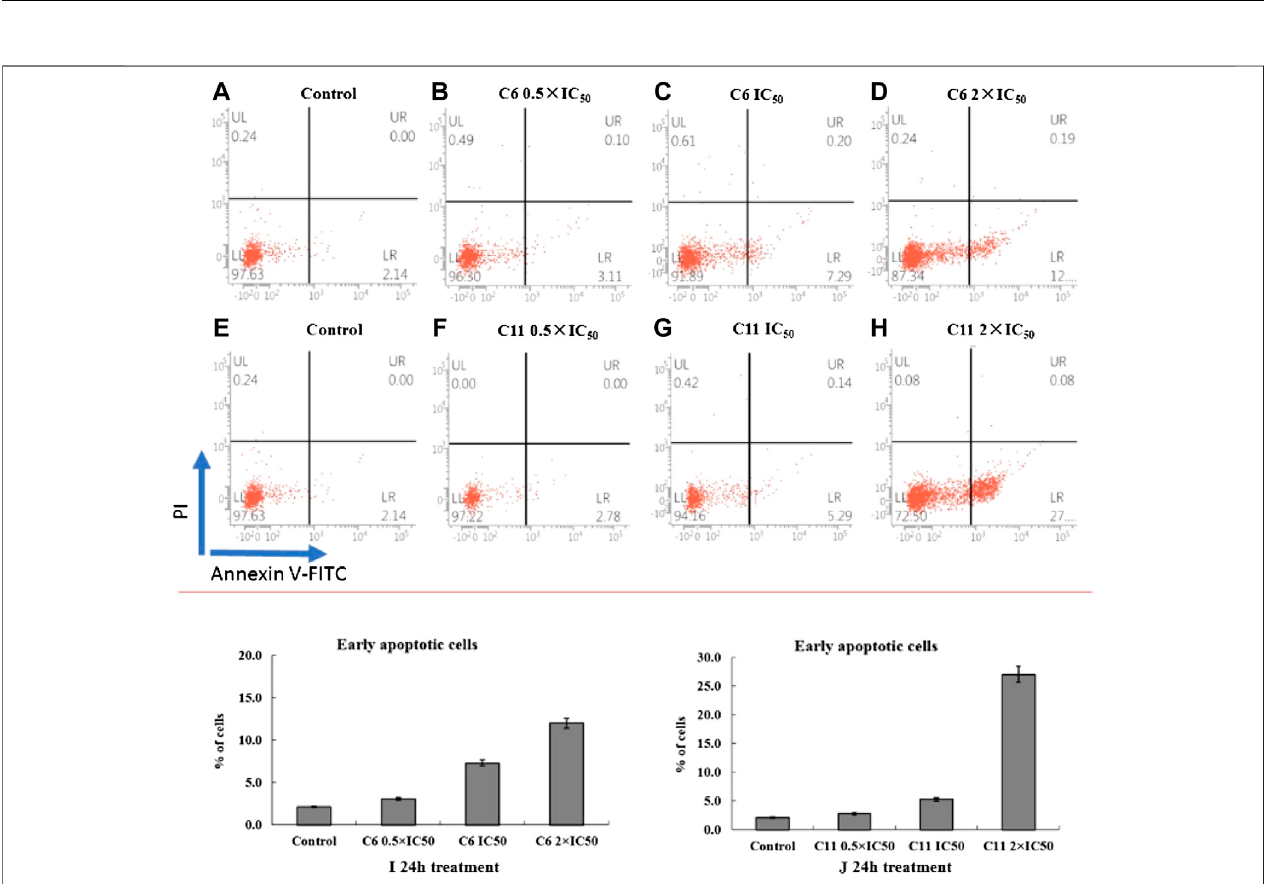
FIGURE 7 | Annexin V-FITC fl ow cytometry. Annexin V-FITC/PI staining was monitored on A875 cells following 24 h treatment with compounds C6 or C11 at concentrations corresponding to their 0.5 × IC 50s , IC 50s or 2 × IC 50s (B – D,F – H) . Representative dot plots of three independent experiments are given, presenting intact cellsatlower-leftquadrant,FITC( − )/PI( − );earlyapoptoticcellsatlower-rightquadrant,FITC(+)/PI( − );lateapoptoticornecroticcellsatupper-rightquadrant,FITC(+)/PI(+); necrotic cells at upper-left quadrant, FITC( − )/PI(+). (I,J) Apoptotic effect of compounds C6 and C11 was evaluated after 24 h treatment; bar graphs represent mean ± SD in at least three independent experiments.